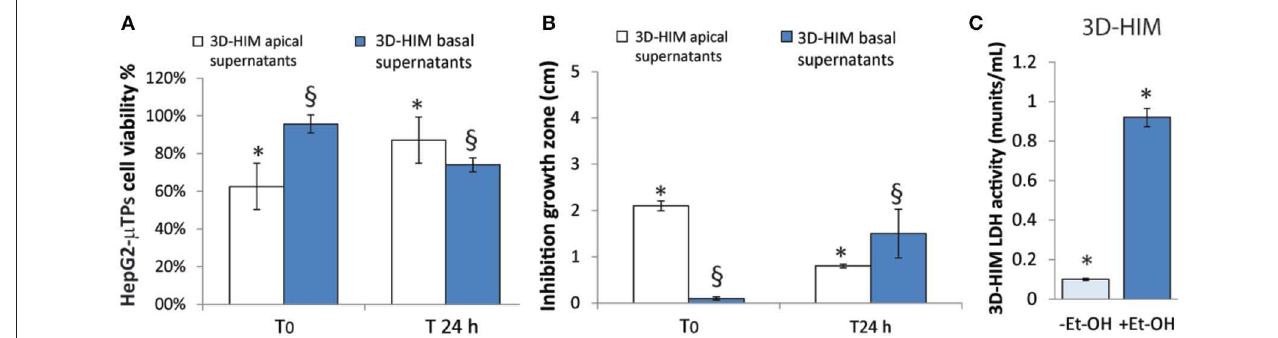
FIGURE 4 | 3D-HIM-metabolized Et-OH effect on HepG2- µ TPs cytotoxicity and L. rhamnosus growth and Et-OH damage on 3D-HIM. MTT cell viability assay displays indirect estimation of the indigested Et-OH treating HepG2- µ TPs with 3D-HIM supernatants (3D-HIM apical and - basal supernatants ) at two different time points (T 0 and 24h) (* p < 0.001; § p < 0.05) (A) ; Zone of Inhibition Test shows the antimicrobial activity of the indigested Et-OH treating HepG2- µ TPs with 3D-HIM supernatants (3D-HIM apical and - basal supernatants ) on L. rhamnosus growth at two different time points (T 0 and 24h) (* p < 0.001; § p < 0.05) (B) ; LDH assay indicates the 3D-HIM toxicity after 400mM Et-OH treatment (C) (* p <